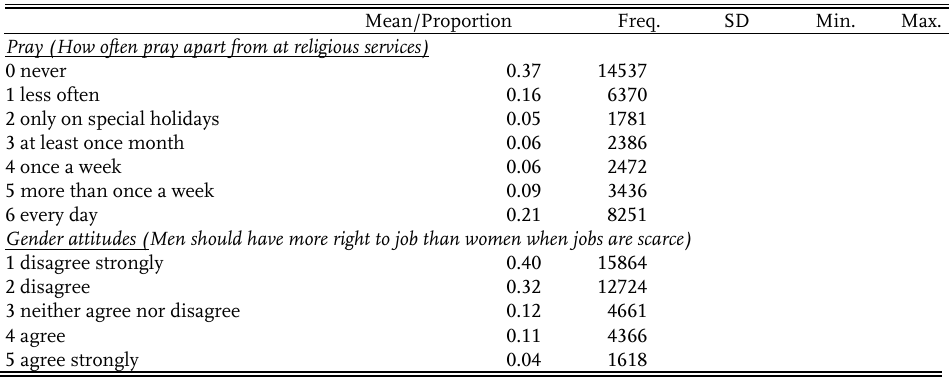
Table A.1 : Unweighted descriptive statistics (N = 43649) (continued) Mean/Proportion Freq. SD Min.